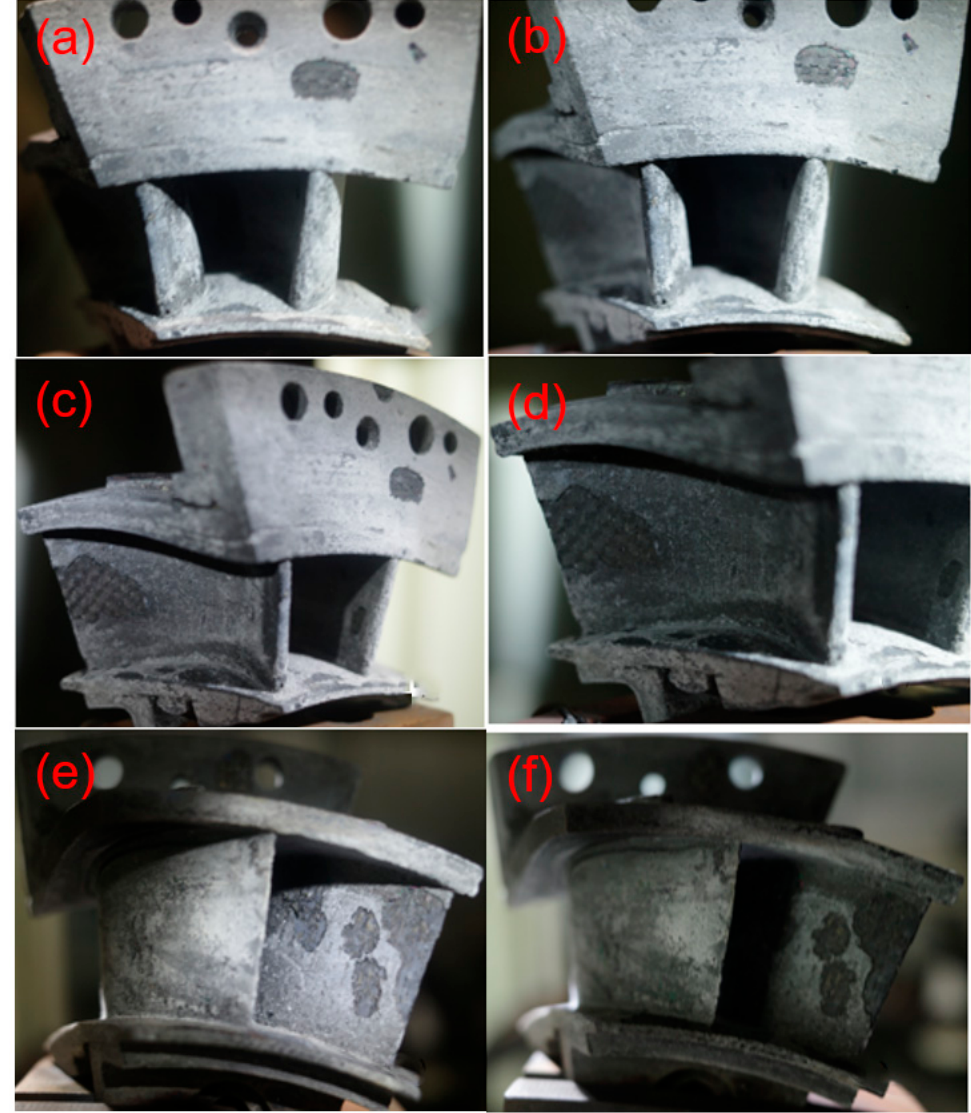
Figure 13. Thermal shock damage of SiC/SiC twin guide vane at target temperature of T = 1480 °C with the hold time of t = 60 s for leading edge at ( a ) N = 100, and ( b ) N = 200, the basin region at ( c ) N = 100, and ( d ) N = 200, and the back region at ( e ) N = 100, and ( f ) N = 200.